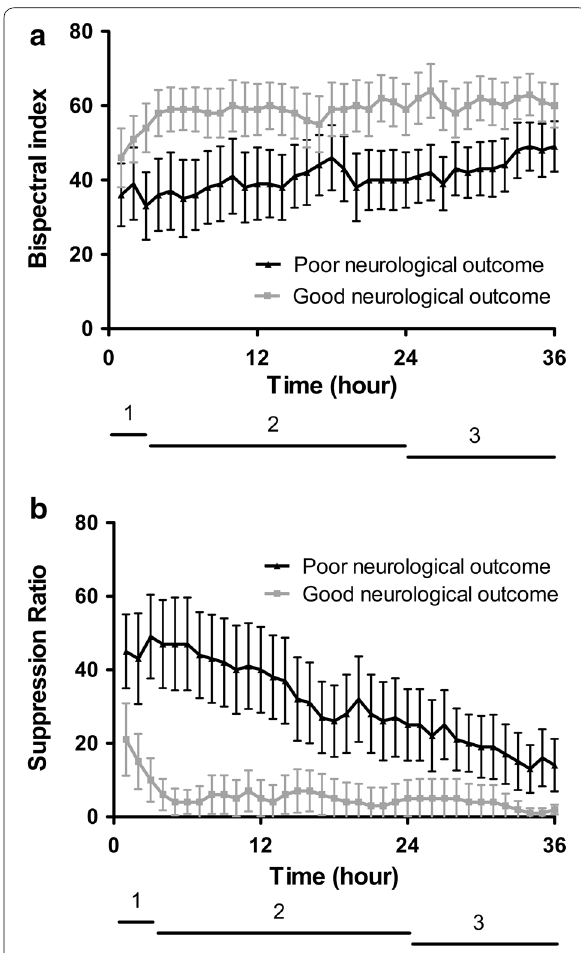
Fig. 1 Evolution of mean BIS and SR during targeted temperature management. Hourly mean BIS ( a ) and SR values ( b ) are shown with their 95% CI in patients with a good and poor neurological outcome. Patients with a poor neurological outcome had significantly higher BIS and lower SR values during (1) the induction phase ( p and p < 0.001, respectively), (2) the hypothermic phase ( p < 0.001 and p < 0.001, respectively) and (3) rewarming phase ( p < 0.001 and p < 0.001,